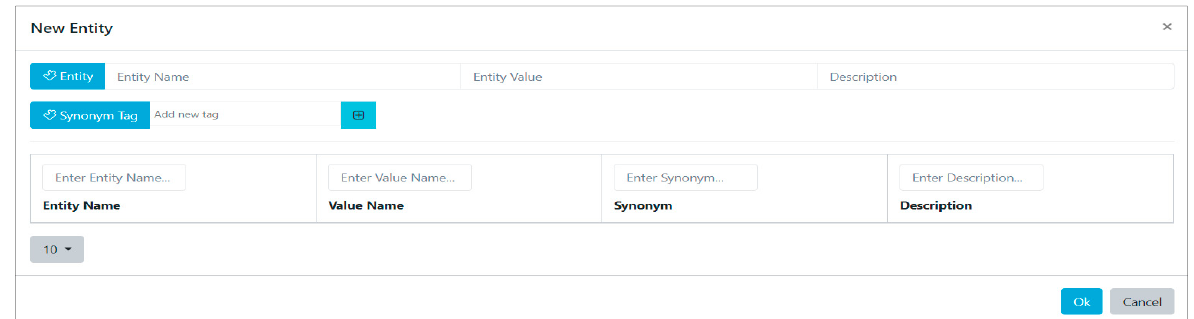
Figure 11. Input interface of chatbot intent data.